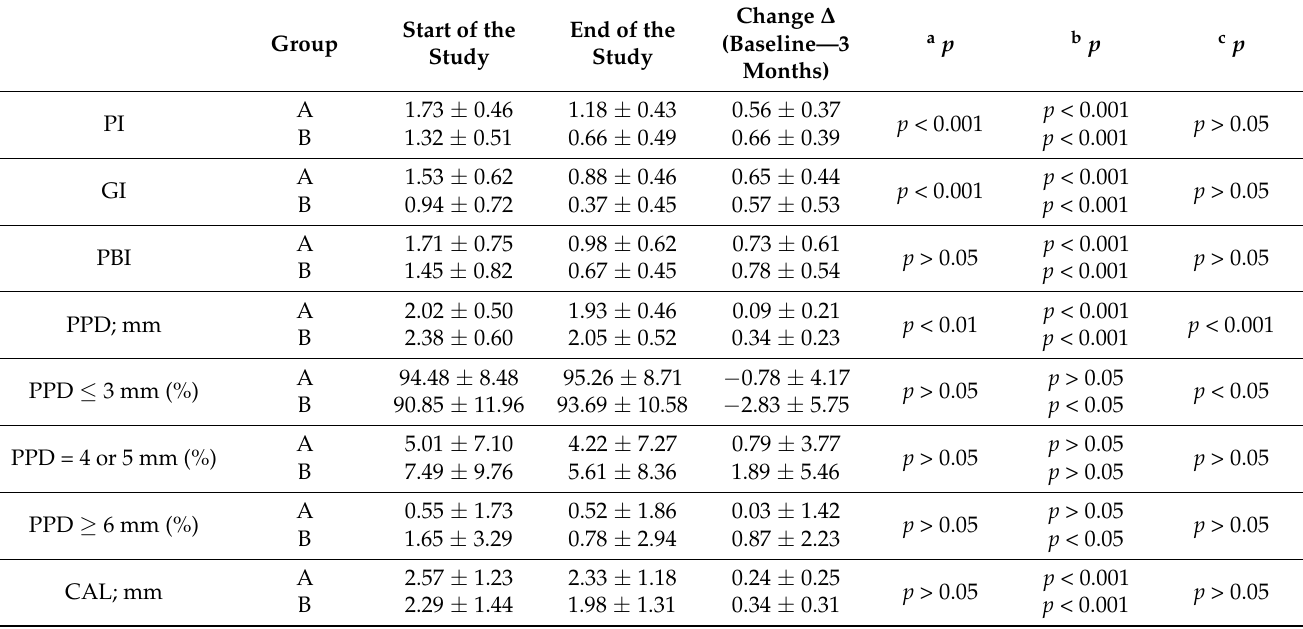
Values are expressed as mean ± SD; ∆ —pre- and post-treatment changes; PI = plaque index; GI = gingival index; PBI = papilla bleeding index; PPD = probing pocket depth; PPD ≤ 3 mm (%)—percentage of pockets with ≤ 3 mm depth; PPD = 4 or 5 mm (%)—percentage of pockets with 4 or 5 mm depth; PPD ≥ 6 mm (%)—percentage of pockets with ≥ 6 mm depth; CAL = clinical attachment level; Group A = DM2 participants; Group B = non-diabetic participants; a p value relates to between-group differences at baseline (Mann-Whitney test); b p value pertains to pre- and post-treatment changes within each group (Wilcoxon signed-rank test); and c p value relates to between-group comparisons of changes in measured parameters (Mann–Whitney